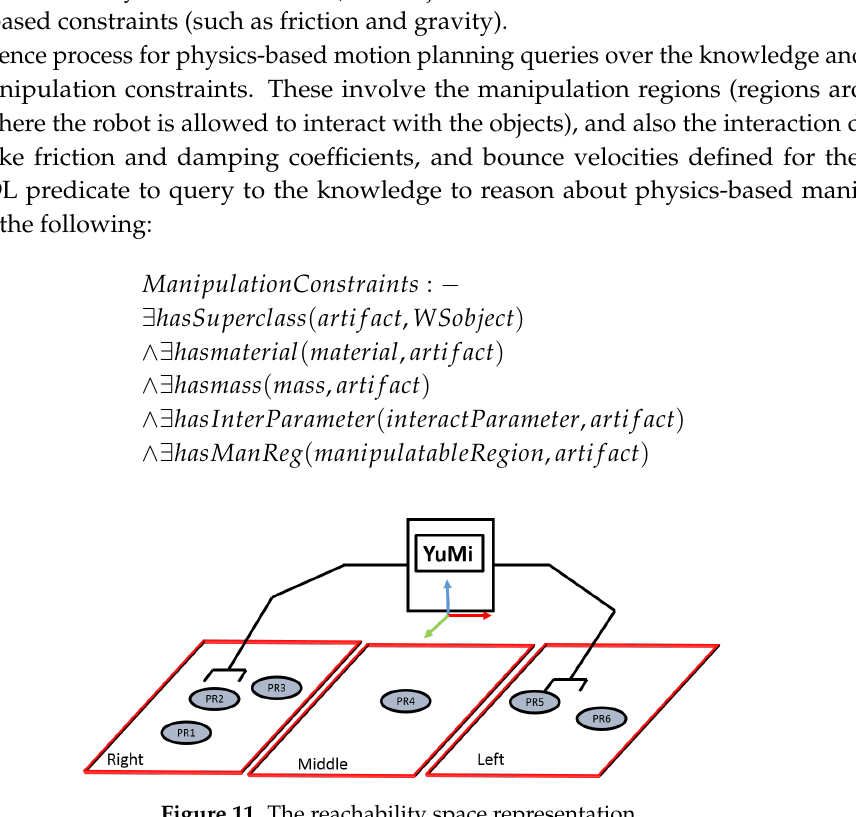
Figure 11. The reachability space